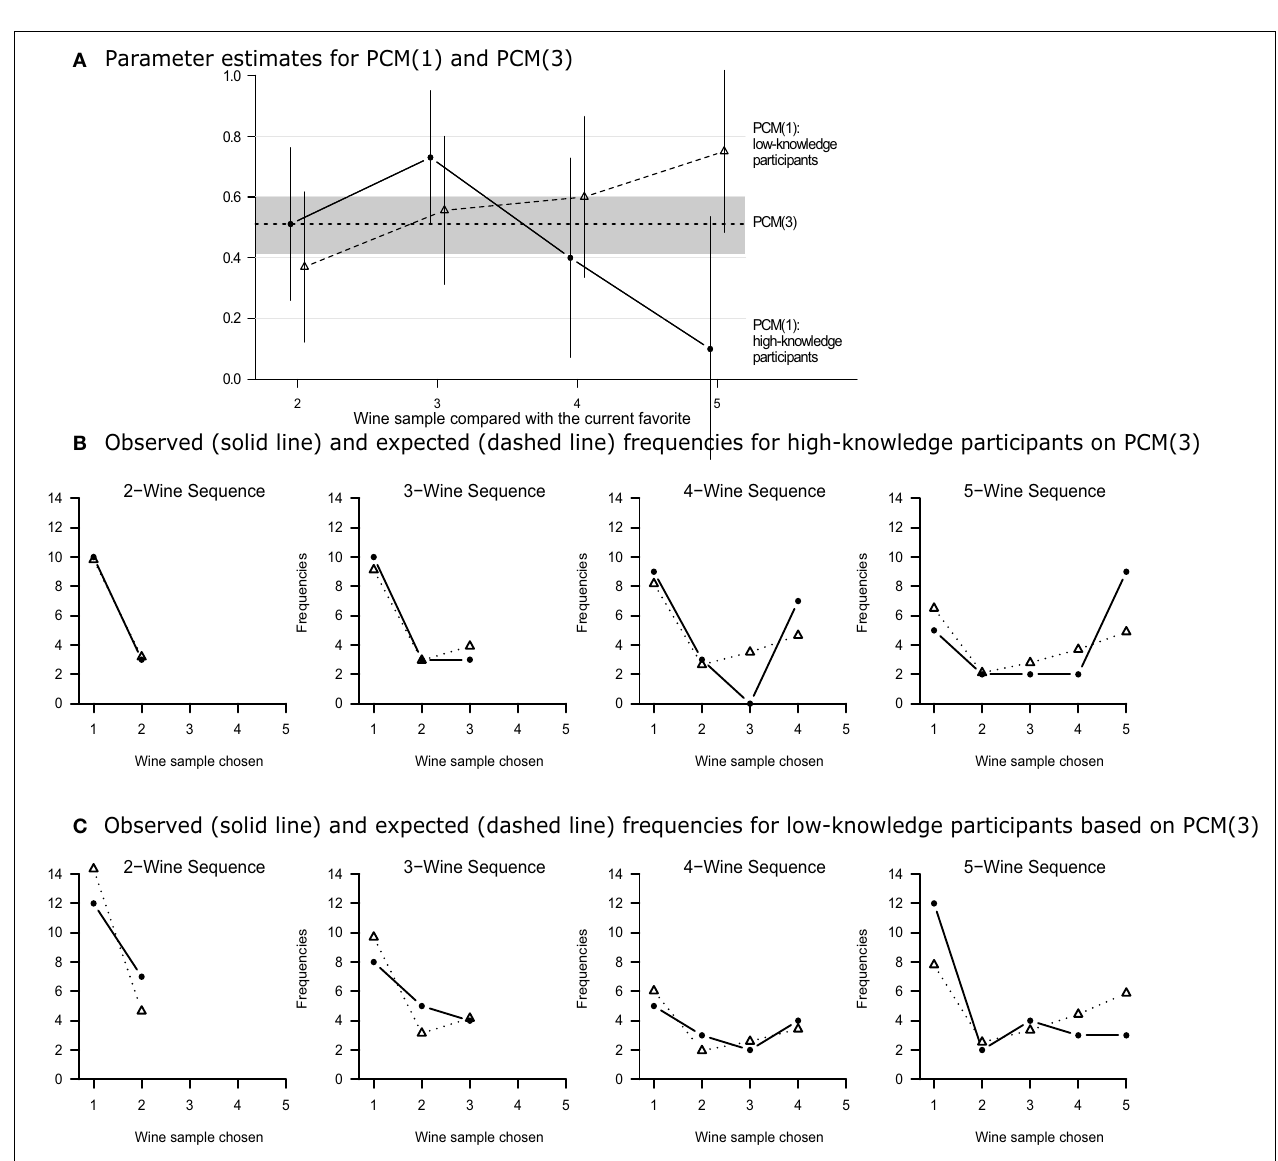
FIGURE 1 | (A) Estimates of the choice inertia parameters of models PCM(1) and PCM(3). Vertical lines indicate 95% confidence intervals for the eight parameters of PCM(1). The gray area illustrates the 95% confidence interval of the single PCM(3) choice inertia parameter. (B,C)